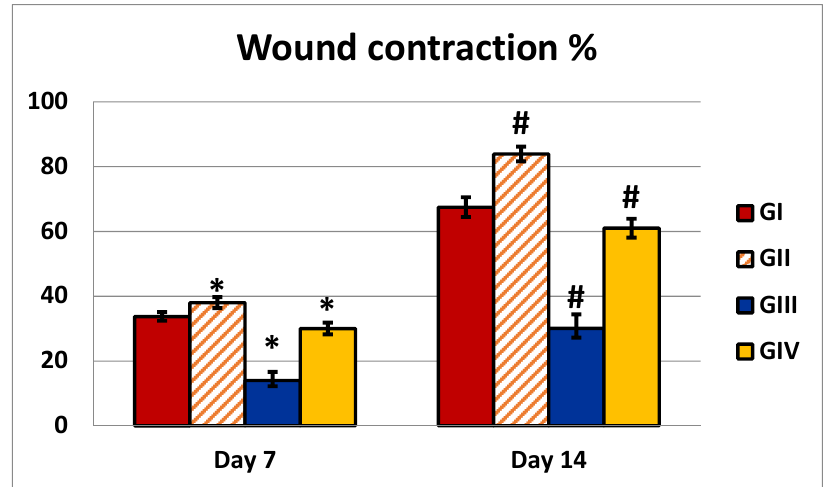
Figure 6. Illustration of an analysis of wounds that were either untreated or treated with DEEL, MRSA, or MRSA + DEEL. Percentage of wound area contraction (wound contraction %) obtained on days 7 and 14. GI: wounded rats treated with normal saline; GII: wounded rats treated with DEEL; GIII: wounded rats infected with MRSA; GIV: wounded rats infected with MRSA and treated with DEEL of C. macrocarpa . Symbols * and # indicate that the group is significant in comparison to the control group (GI) at p ≤ 0.001 after 7 and 14 days, respectively. Int. J. Environ. Res. Public Health 2020 , 17 , x FOR PEER REVIEW